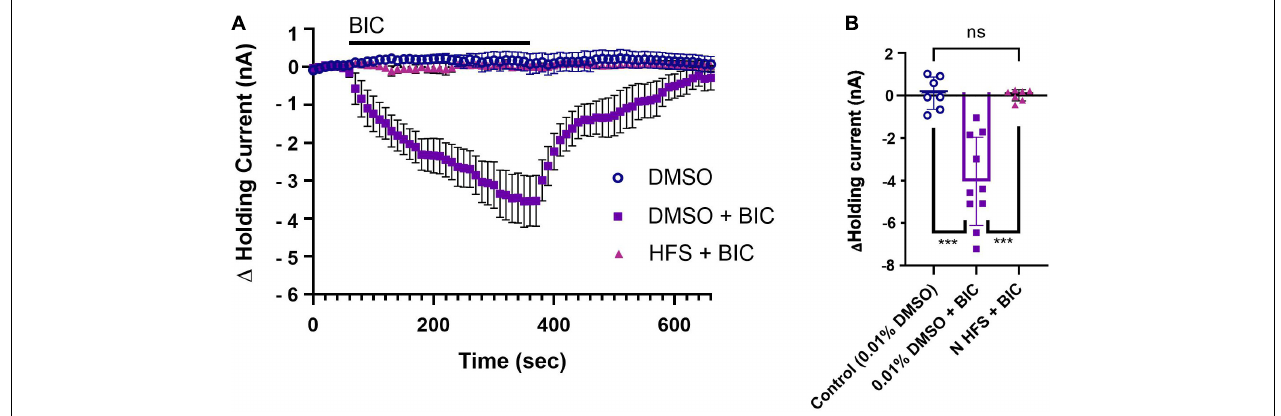
FIGURE 2 | N cell HFS depresses tonic inhibition in the P cell. (A) A substantial shift in the P cell holding current is observed during 100 µ M BIC application (DMSO + BIC group) compared to the control group that simply had the holding current monitored in vehicle control, saline with 0.01% DMSO (referred to as the DMSO group). Recall that the 0.01% DMSO in saline is applied 30 min prior to BIC application as a vehicle control experiment (see section “Materials and Methods” and Figure 1C ). N cell HFS applied 30 min before BIC application (HFS + BIC) fully prevented the negative shift in P cell holding current in response to BIC and is shown to be overlain on the control group that did not receive BIC. (B) When comparing the peak change in holding current during BIC bath-application, changes in holding current were significantly reduced in the HFS + BIC group compared to the only DMSO + BIC group ( ∗∗∗ indicates p < 0.0001). No difference in peak current was observed between the N cell HFS + BIC group and the DMSO group. All data is shown as mean ±